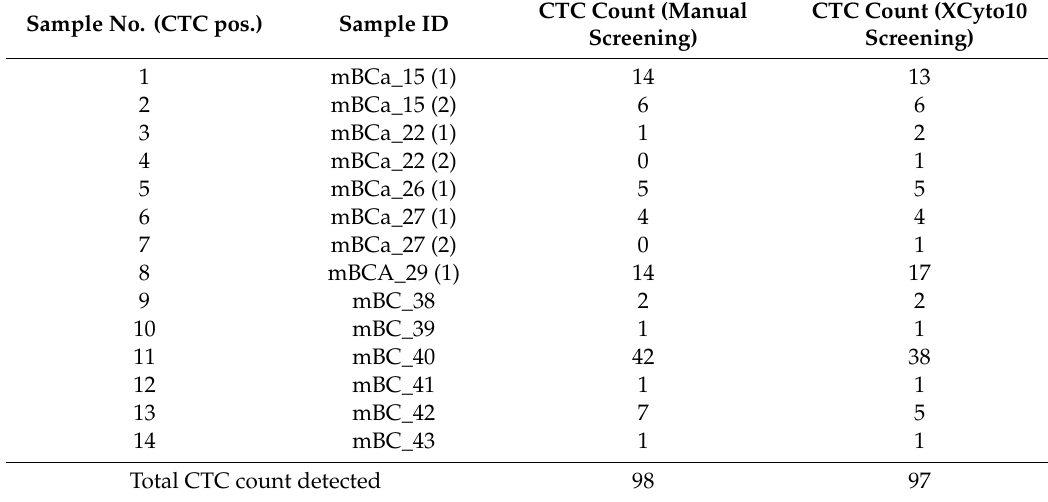
Table 3. Summary of CTC-positive mBC patient samples and their corresponding CTC counts analyzed by either manual or XCyto ® 10 -based semi-automated screening. Cases in which one approach yielded higher CTC counts are marked in bold. The evaluation contains CTC-positive samples from prior analysis (Table S3) as well as 6 additional CTC-positive mBC samples (Table S3, Sheet 2). In the cases of “re-evaluated” samples (1) indicates samples processed via the 6.5 µ m cassette gap and (2) samples that were separated via the 10 µ m gap size. The 6 additional blood samples were solely processed using the narrow 6.5 µ m cassette gap. All samples were drawn in